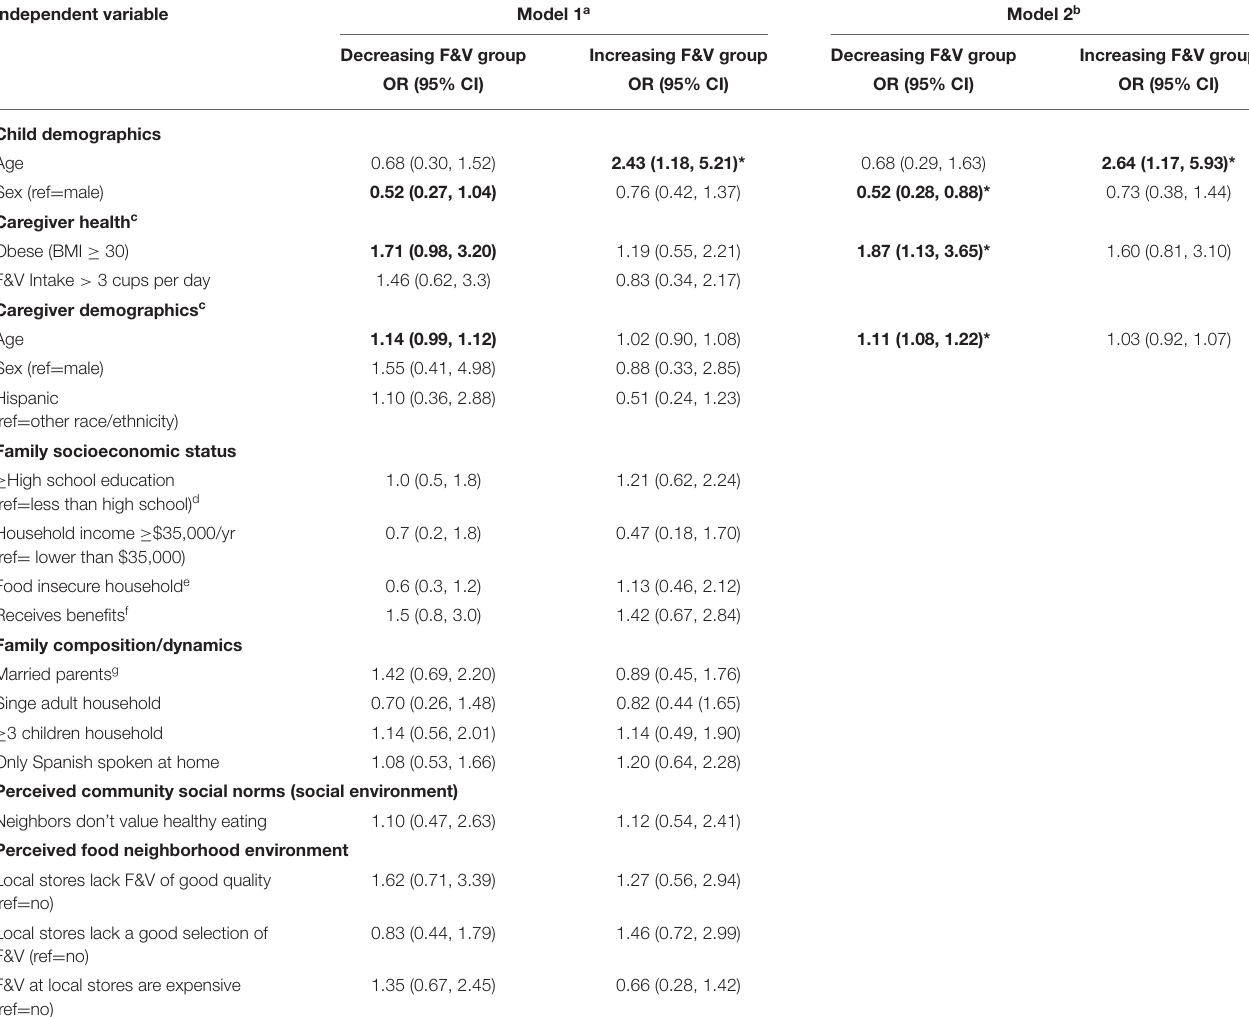
TABLE 4 | Associations between baseline ecological characteristics and child fruit & vegetable (F&V) daily intake change status from baseline to follow-up (referent is “no change” group); Go Austin! Vamos Austin! cohort (2013–2017; n =